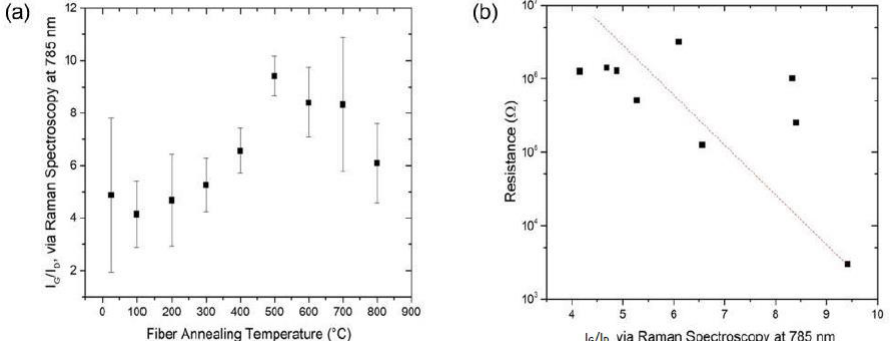
Figure 4. ( a ) Relative intensity of the G- and D-peaks in the resonant Raman spectra for CNT fibers at 785 nm as a function of annealing temperature in the nanoprobe and ( b ) electrical resistance of the CNT fibers as a function of the relative intensity of the G- and D-peaks. There is a general inverse relation of electrical resistance with I G /I D .